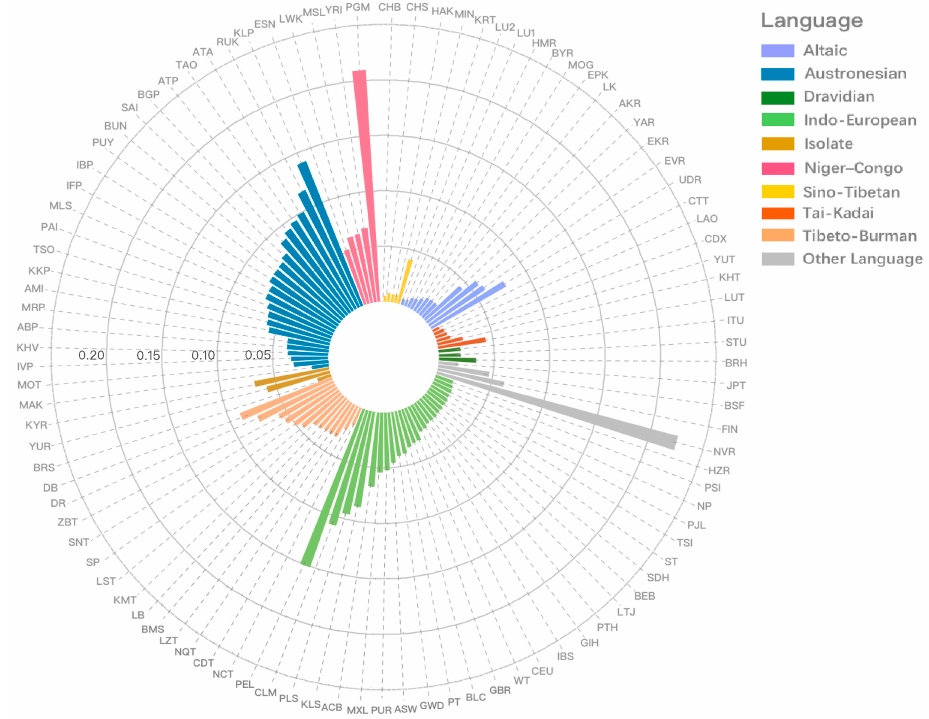
Figure 3. A circle histogram of pairwise F ST values between Hui and 99 worldwide populations based on the haplogroup frequencies.